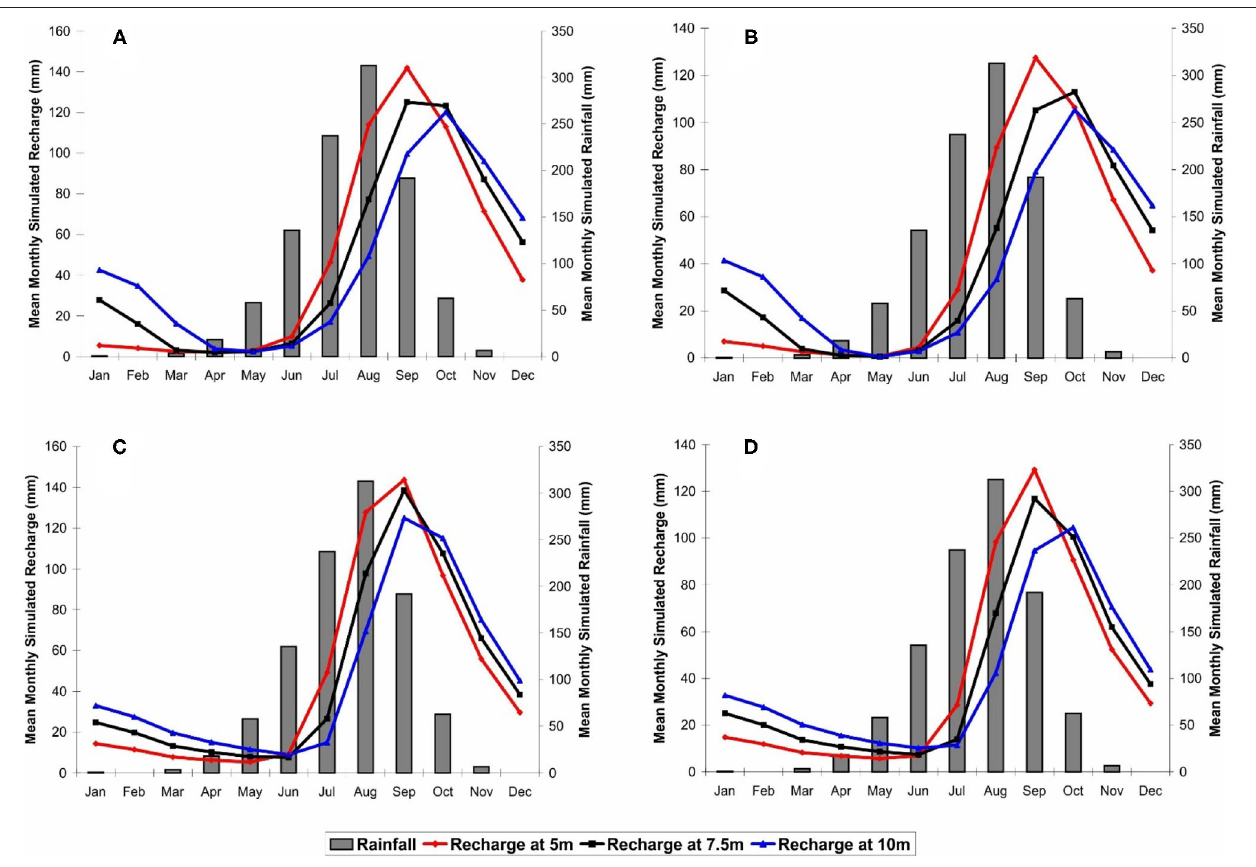
FIGURE 7 | Mean monthly recharge (left y-axis) and mean monthly precipitation (right y-axis) at three depths for 30 years of simulation for (A) Group 1, (B) Group 2, (C) Group 3, and (D) Group 4.